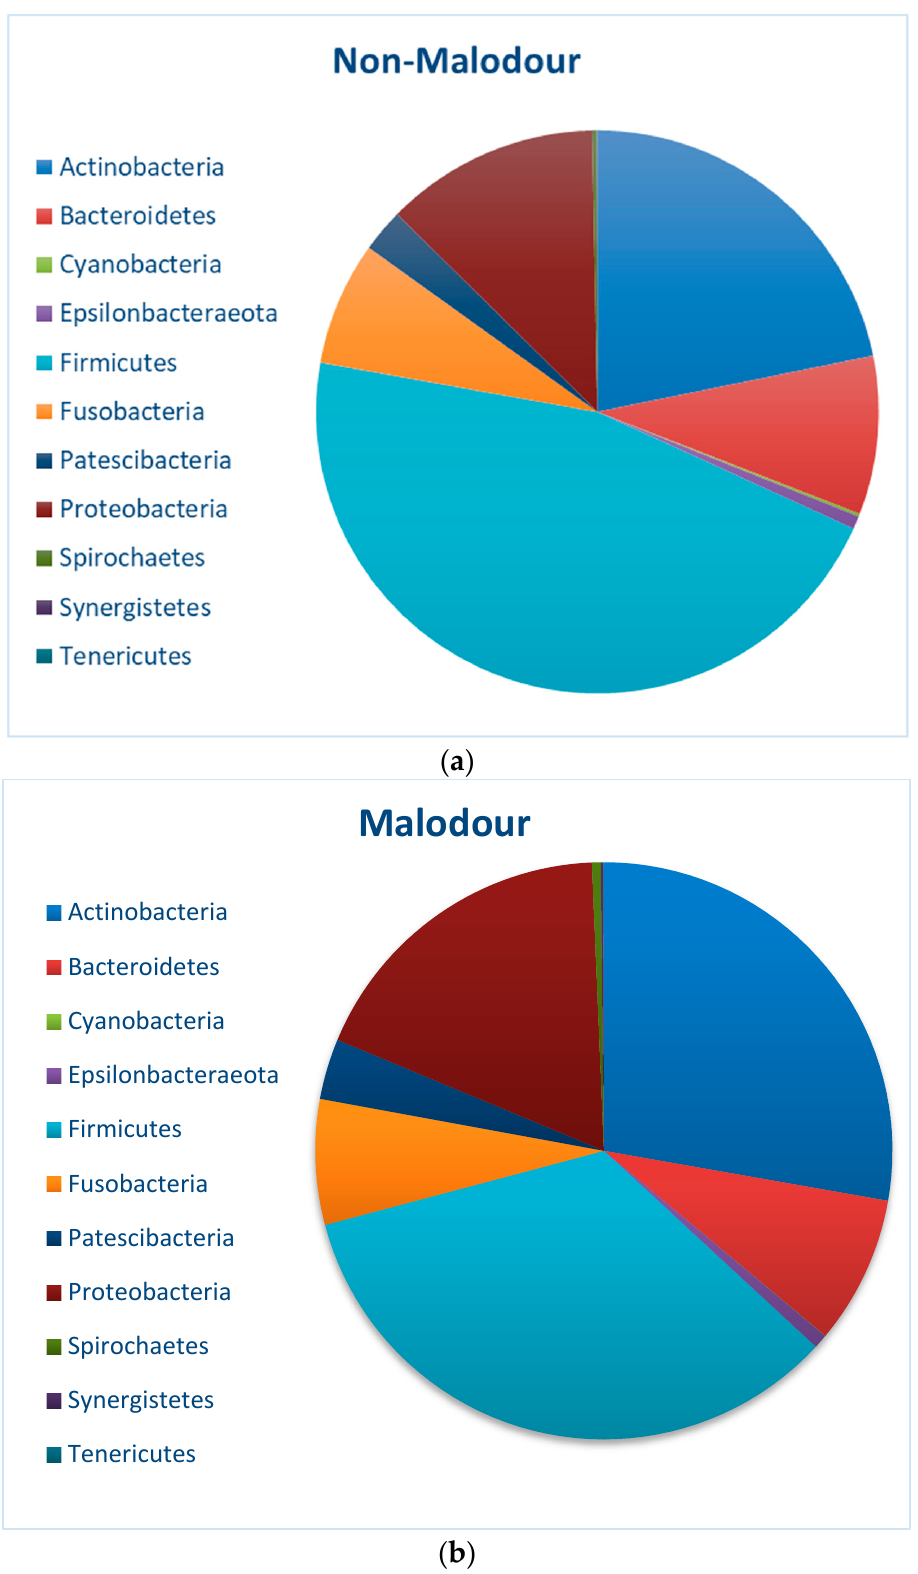
Figure 1. Microbial abundance at phylum level for ( a ) non-malodor samples and ( b ) malodor samples.